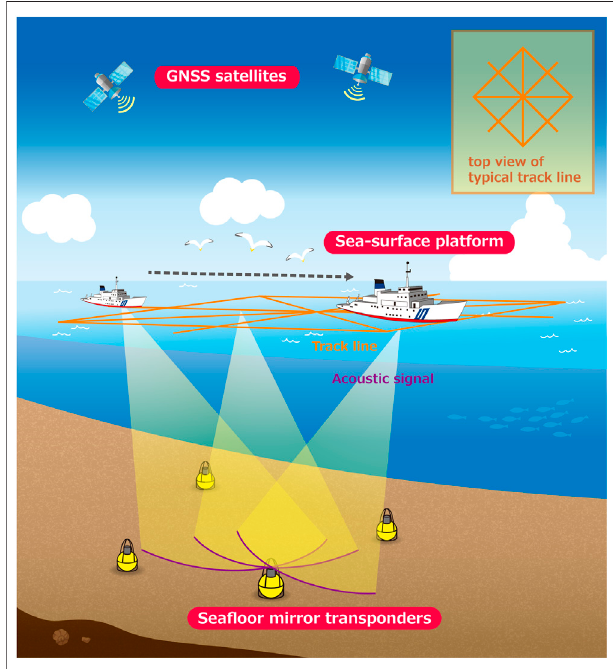
FIGURE 1 | Schematic image of the GNSS-A system in the move- around con fi guration.